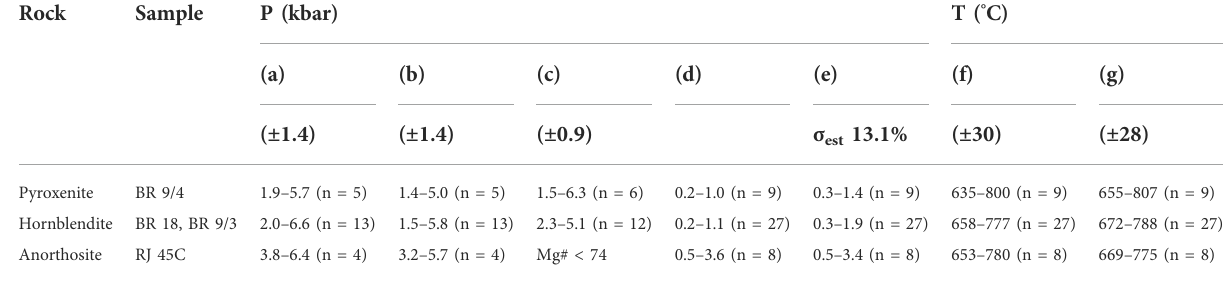
TABLE 3 Pressure and temperature of amphibole crystallization in pyroxenite, hornblendite, and anorthosite samples from the study area.